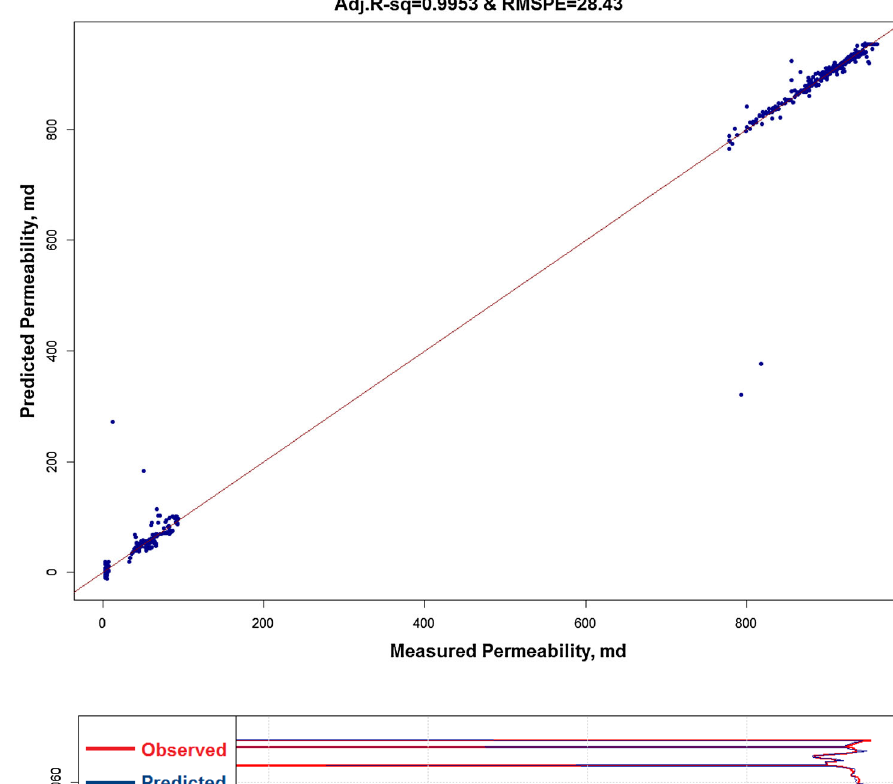
Fig. 8 Matching between the entire vertical predicted and observed core permeability distributions by GBM